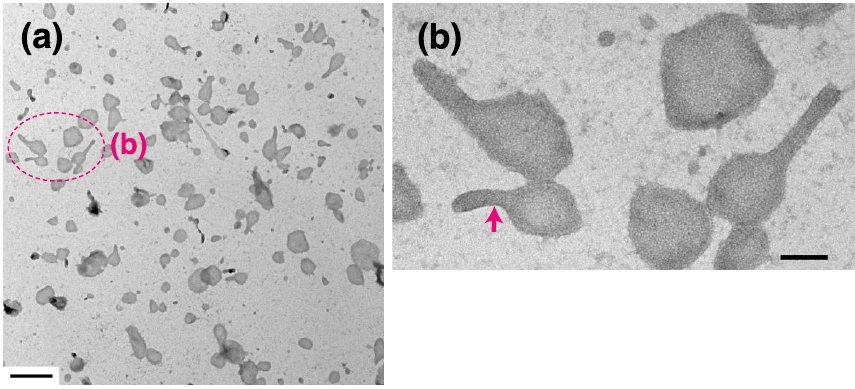
Figure 6. SR vesicles at 86 nM Ca 2+ in the presence of ATP at 0 °C. ( a ) Low magnification image of the vesicles. ( b ) Higher magnification of the annotated area surrounding the tightly elongated vesicles (arrow). The vesicles have a crystal-array of particles. Scale bar in ( a ): 0.5 µm. Scale bar in ( b ): 100 nm.